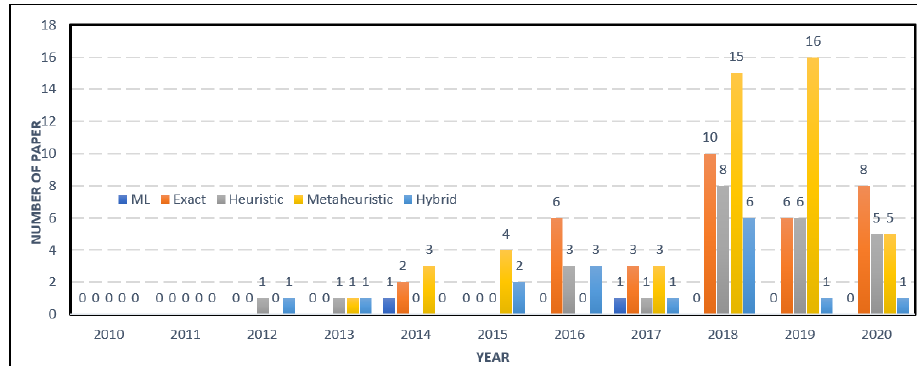
Figure 39. Solution Approaches Applied in Literature According to Year of